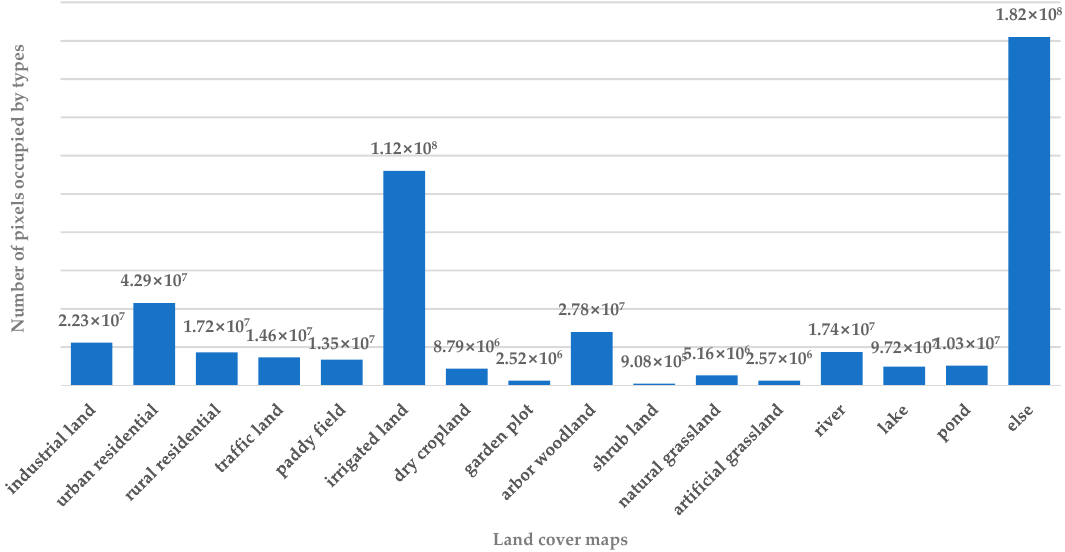
Figure 4. Gaofen Image Dataset (GID) distribution.